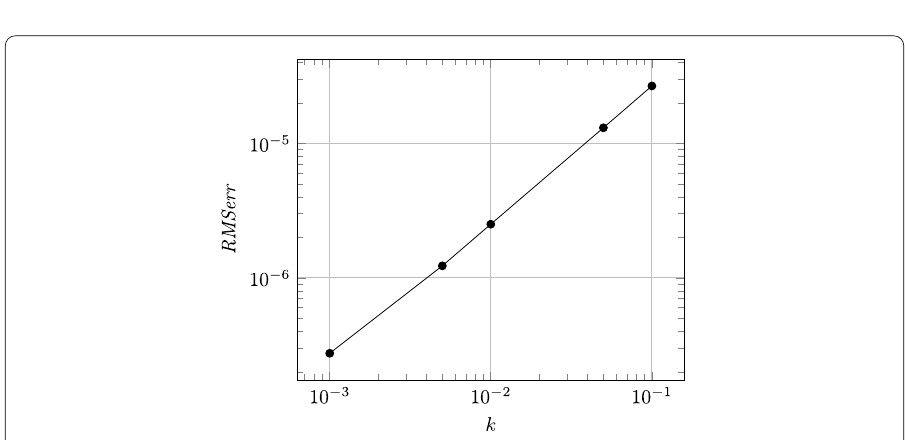
Figure 5 The RMS err as a function of k : N = 7, N e = 20 for Example 5.1